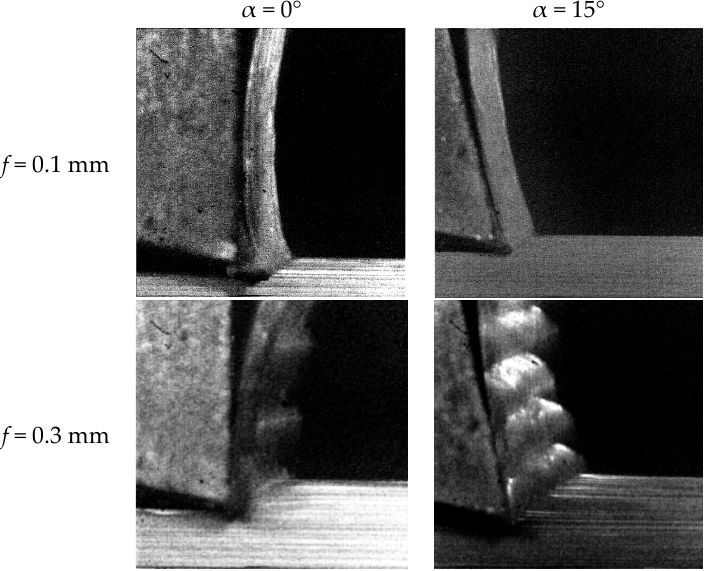
Figure 3. Example of experimental chips morphology obtained with cutting speed = 60 m/min. Table 2. Average cutting force, feed force and contact length for different cutting speeds [12].